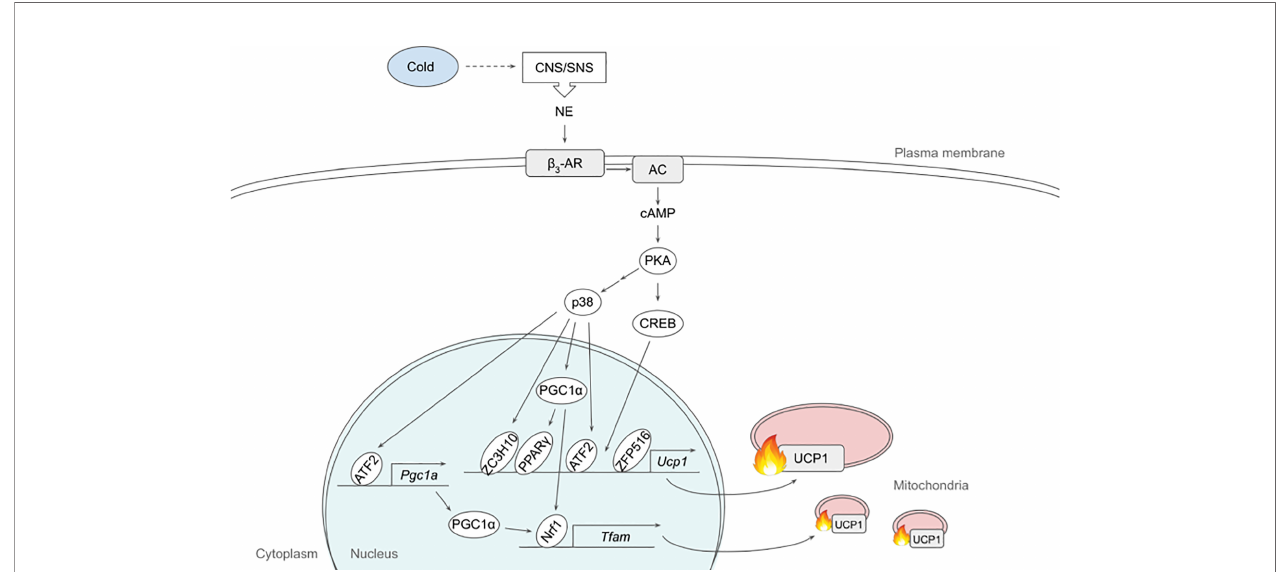
FIGURE 1 | Schematic model of b 3 -adrenergic signaling pathway that promotes thermogenesis in adipocytes. Cold stimulates CNS/SNS to secrete NE that binds b 3 -AR, which then activates AC producing cAMP. cAMP in turn activates PKA that has a variety of downstream targets, including transcription factors to upregulate thermogenic gene expression. See text for details. AC, adenylate cyclase; ATF2, activating transcription factor 2; b 3 -AR, b 3 -adrenergic receptor; CNS, central nervous system; CREB, cAMP response-element binding protein; ETC, electron transport chain; FFA, free fatty acid; IRF4, interferon regulatory factor 4; NE, norepinephrine; NRF1, nuclear respiratory factor 1; PGC1 a , peroxisome proliferator activated receptor g coactivator a ; PKA, protein kinase A; PPAR g , peroxisome proliferator activated receptor g ; SNS sympathetic nervous system; TCA, tricarboxylic acid; TFAM, mitochondrial transcription factor A; UCP1, uncoupling protein 1; ZC3H10, zinc fi nger CCCH-type containing 10; ZFP516, zinc fi nger protein 516.